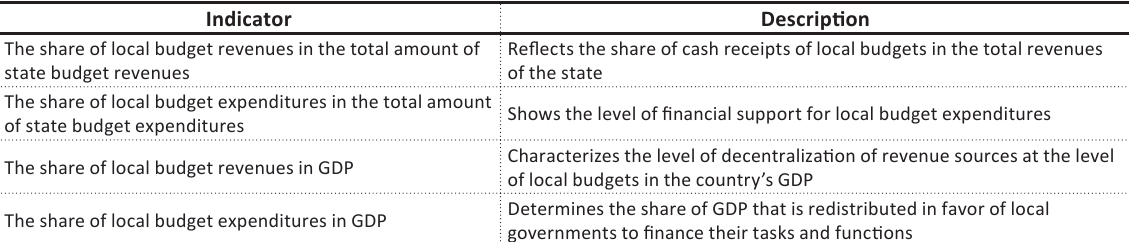
Table 1. Generally accepted indicators of the state and development of local budgets